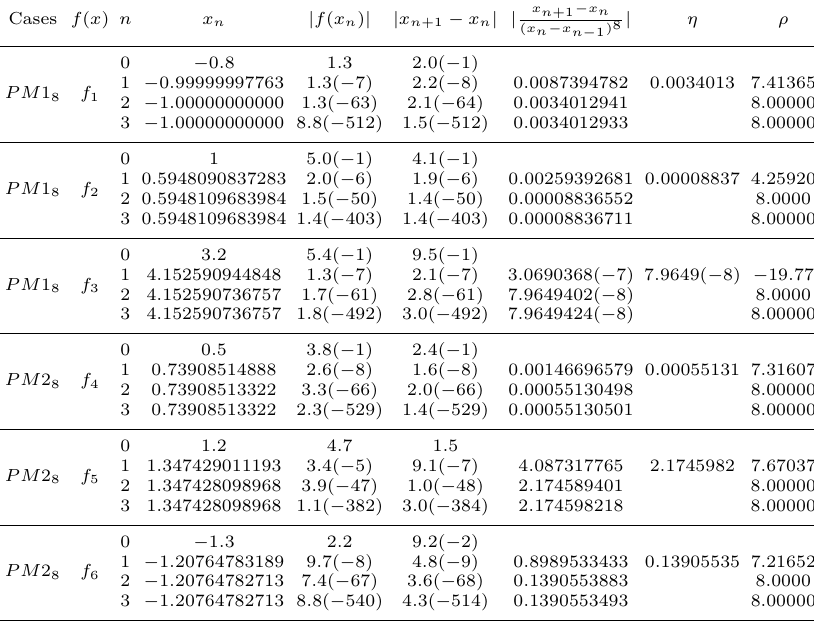
Table 1. Convergence behavior of methods PM 1 8 and PM 2 8 on f 1 ( x ) – f 6 ( x ) Cases f ( x )